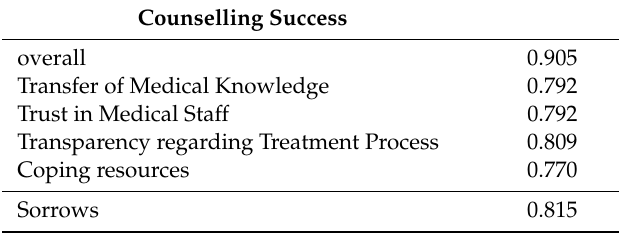
Table 1. Internal consistency of the questionnaire (Cronbach’s alpha = reliability coe ffi cient with values from 0 to 1.0; > 0.7 shows su ffi cient and > 0.8 good internal consistency of the created